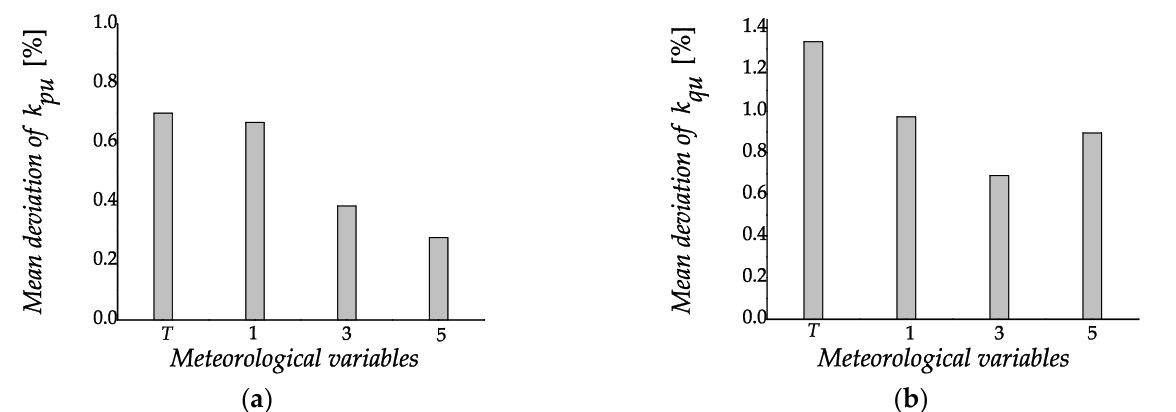
Figure 3. Mean values of deviations of: ( a ) k pu , ( b ) k qu ; obtained when ambient temperature T and 1, 3 and 5 meteorological variables are used.